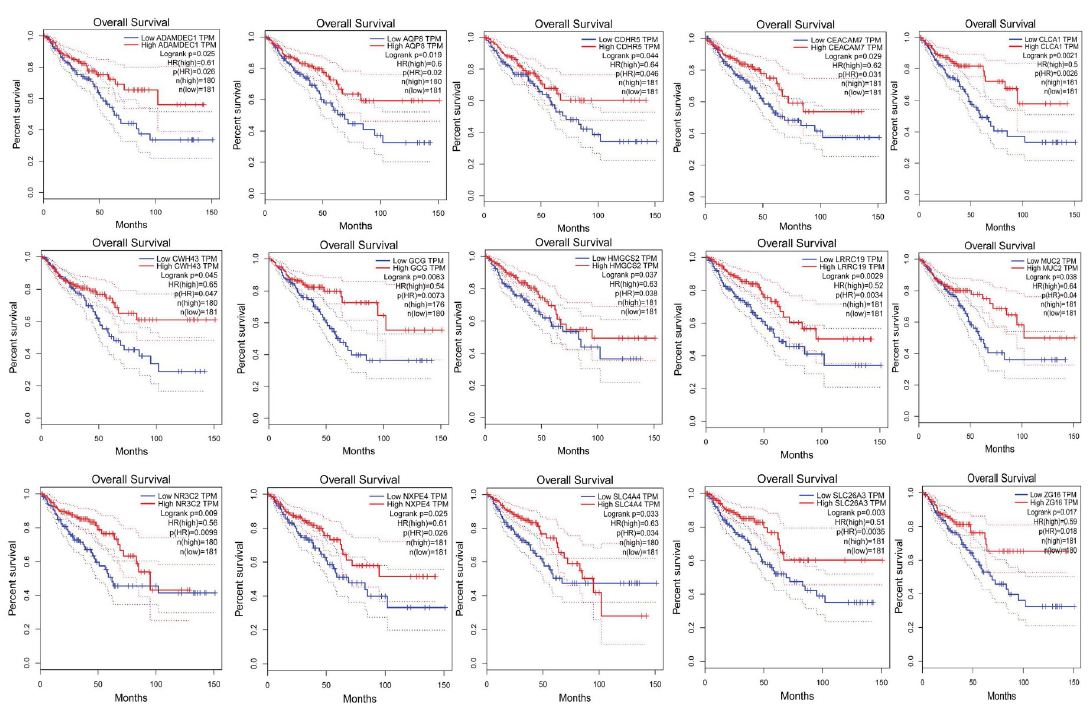
Fig 22. Kaplan-Meier plots of statistically significant under-expressed validated Differentially Expressed Genes. Each pale blue line corresponds to low expression in COAD or READ cancer types. Each pale red line corresponds to high expression in COAD or READ cancer types. The bold blue line represents some kind of average of low expression in two cancer types. The bold red line represents some sort of average of high expression in two cancer types.